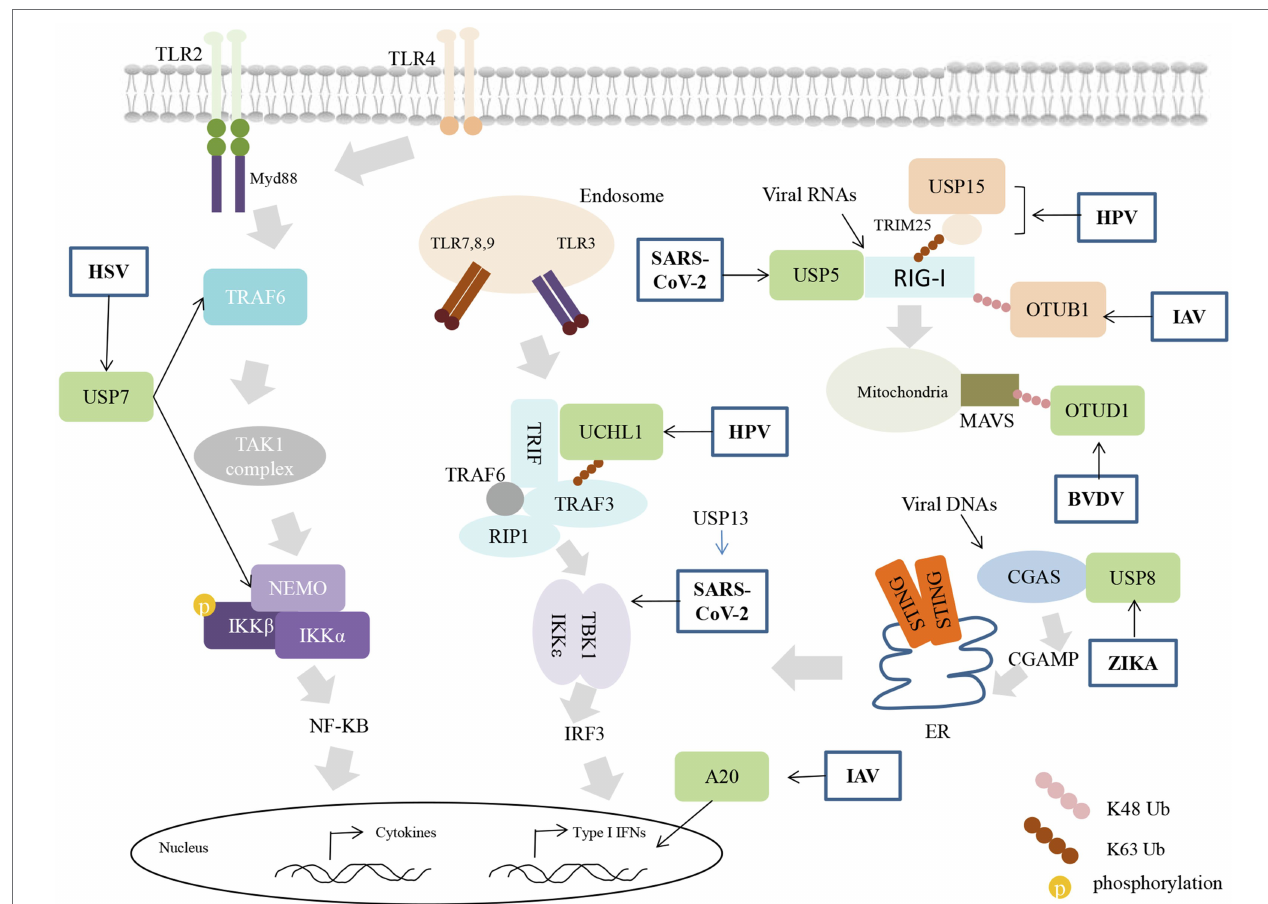
FIGURE 2 | Viruses inhibit innate immunity using cellular DUBs activity. Viral infection induces a cascade of immune signals resulting in the expression of interferon (IFN)-I. Viruses utilize the host’s DUB to block different steps of the antiviral response. Cellular DUBs that positive or negative regulate the signaling are shown with orange or green color,